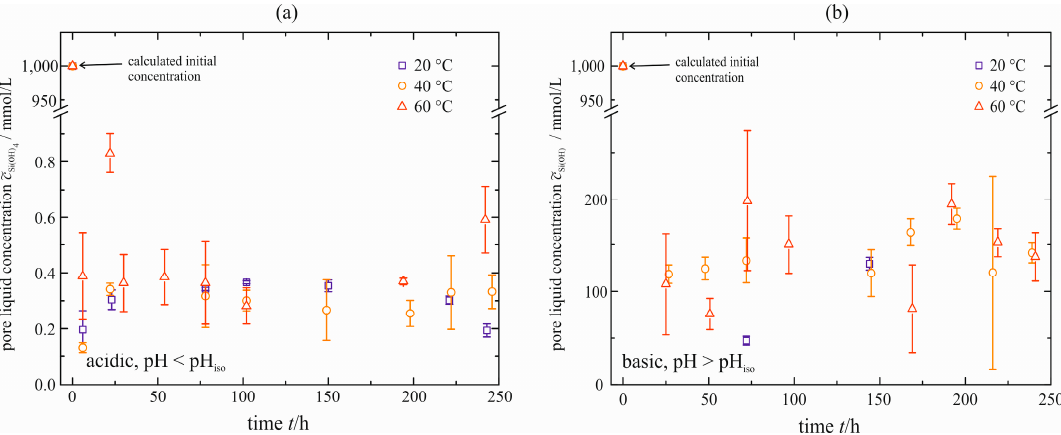
Figure 9. Concentration of monomeric silicic acid in the pore liquid of cylindrical samples, acid-catalyzed ( a ) and base-catalyzed ( b ), natural syneresis.